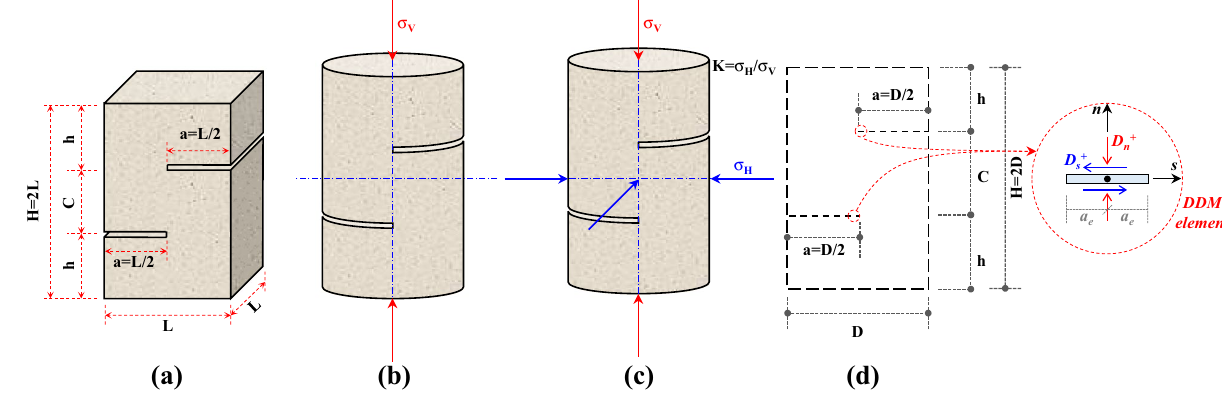
Figure 2. Short core in compression test, ( a ) short beam in compression (SBC), ( b ) short core in compression under uniaxial stress state, ( c ) short core in compression under confined stress state, ( d ) modelling of SCC samples using displacement discontinuity method.